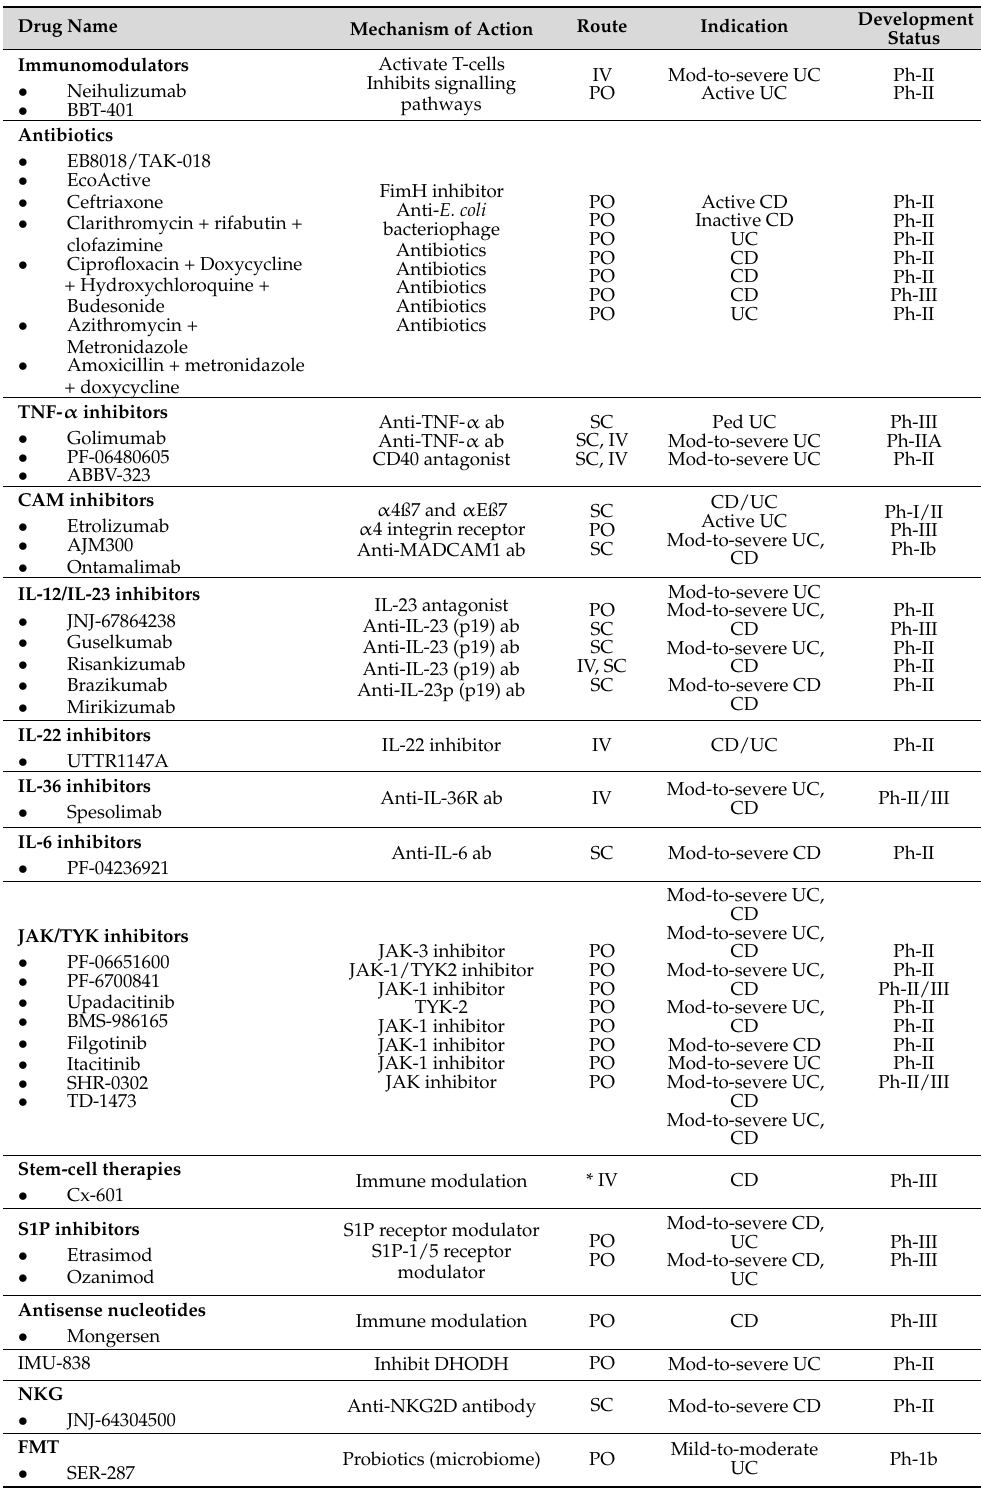
Table 3. Emerging therapies for UC and